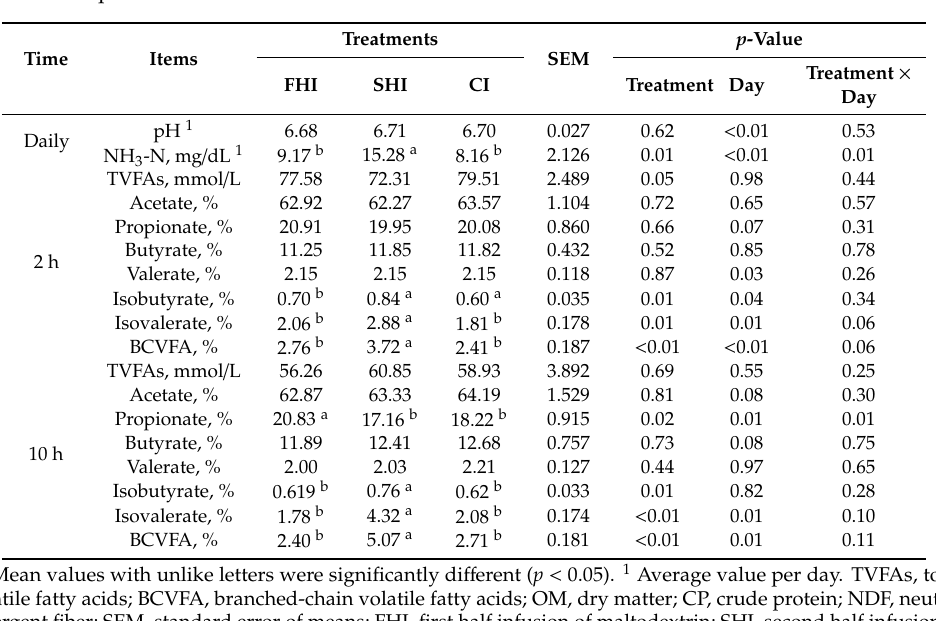
Table 3. E ff ect of treatments with varying degrees of synchronization on in vitro fermentation parameters.